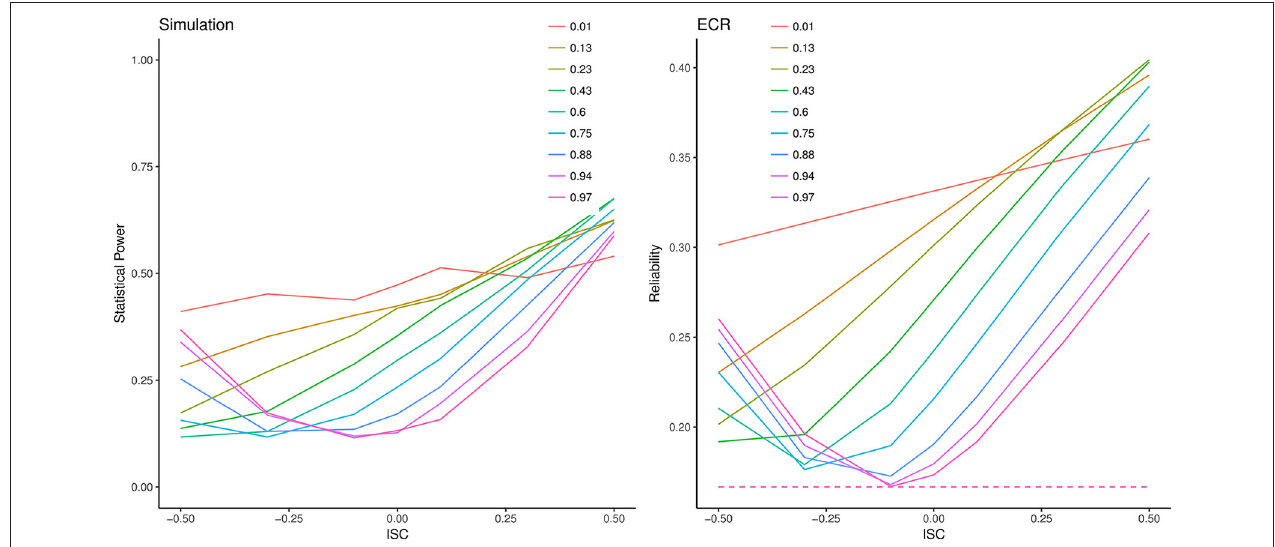
FIGURE 5 | Statistical power and effective curve reliability (ECR) values for the 2-df generalized variance test as a function of intercept-slope correlation (ISC). Left : Lines are Monte Carlo estimates of statistical power of the generalized variance test, with each line representing a model with different intercept variance scaled as the intra-class correlation coefficient (ICC 2 ). Right : Corresponding ECR (solid lines). GRR is constant for all conditions shown here.